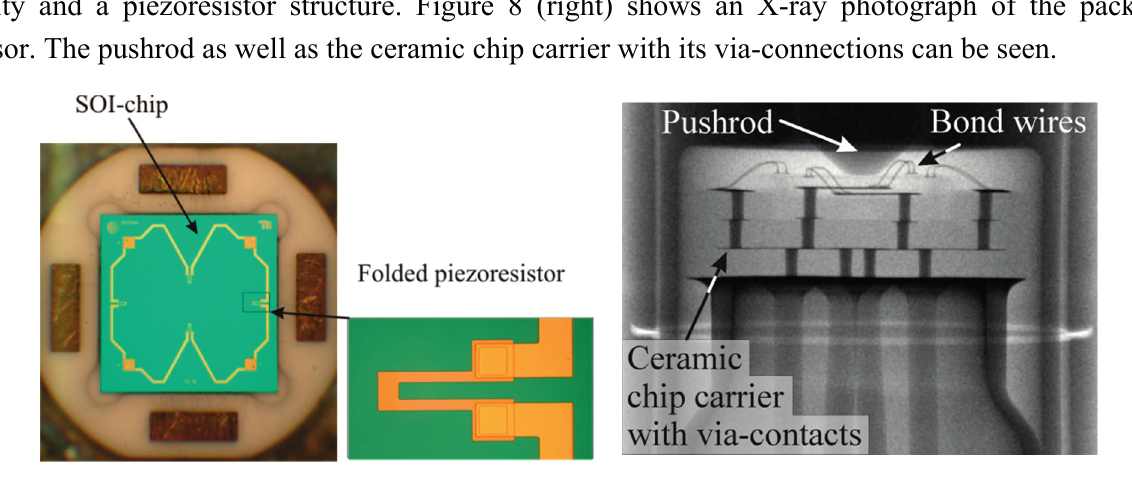
Figure 8. Left —top view of SOI-pressure sensor chip placed in ceramic carrier cavity (dotted line indicates centerboss membrane) with detailed view of folded piezoresistor; Right —X-ray photograph of the packaged sensor. The bond wires, pushrod and the feed through are visible